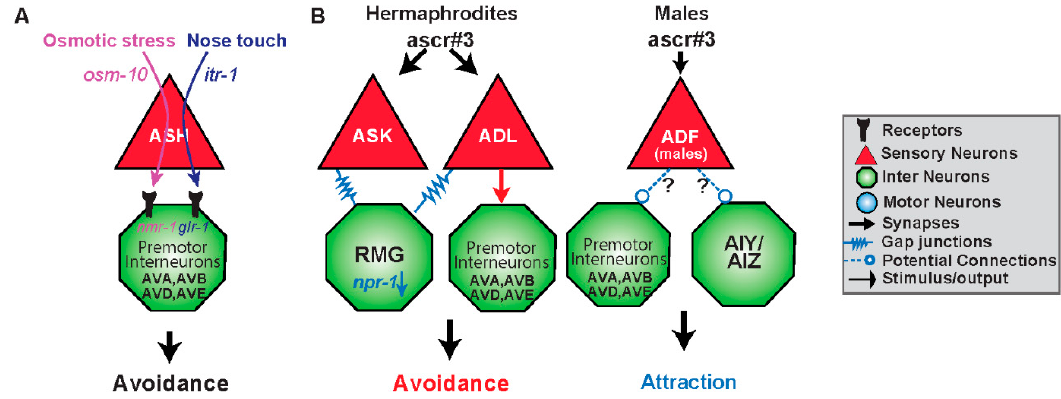
Figure 3. Functional circuits are created by di ff erential use of neurons and distinct intra- and intercellular signaling pathways. ( A ) The sensory neuron ASH responds to two di ff erent stimuli resulting in an avoidance response via the premotor interneurons AVA, AVB, AVD and AVE. Osmotic stress is mediated via osm-10 whereas nose touch utilizes itr-1 within ASH. Downstream of ASH, osmotic stress targets the N-methyl-D-aspartate (NMDA)-type receptor nmr-1 , whereas nose touch activates the glutamate receptor glr-1 in the premotor interneurons [86,88]. ( B ) Gender and type of synapse govern behavioral output to the same stimulus. ADL senses the ascaroside, ascr#3, and in solitary hermaphrodites (high npr-1 ) results in avoidance via electrical synapses. However, hermaphroditic animals with low npr-1 activity dampen or even reverse the valence of response to ascr#3 by the hub-and-spoke gap junction circuit, specifically ASK and RMG. Gender also shapes the response to ascr#3. Males are also able to detect ascr#3 via the masculine mab-3 expressing state of ADF and are attracted to the compound. It is likely that ADF is opposing the ADL promoted avoidance response either via input to command interneurons or the first layer amphid interneurons it synapses